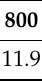
Table 2. Effect of annealing temperature on the average grain size of Ti 50 Ni 47 Fe 3 Table 2. E ff ect of annealing temperature on the average grain size of Ti 50 Ni 47 Fe 3 alloys. Annealing Temperature/°C